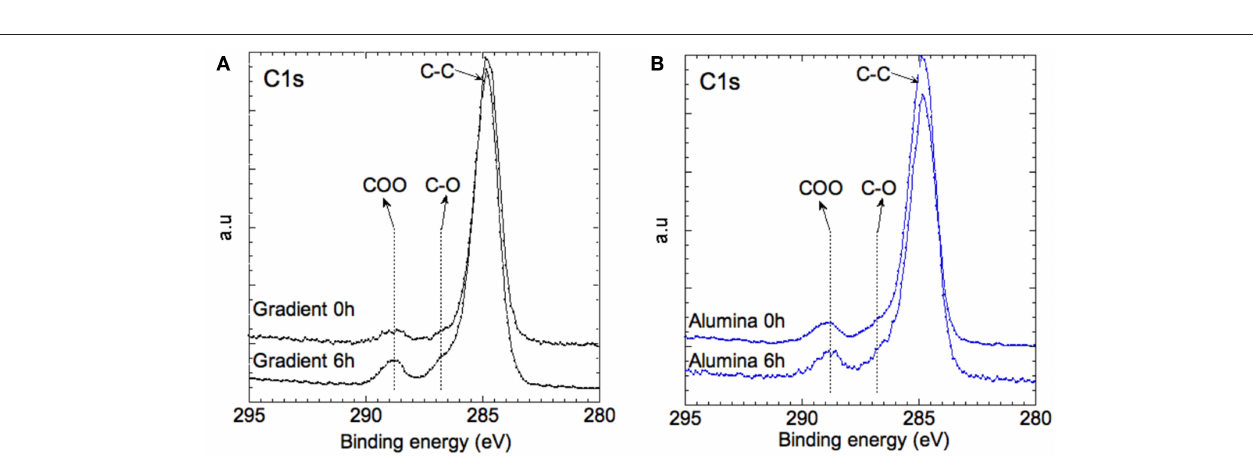
energies is observed for the gradient QDs after 6 h of